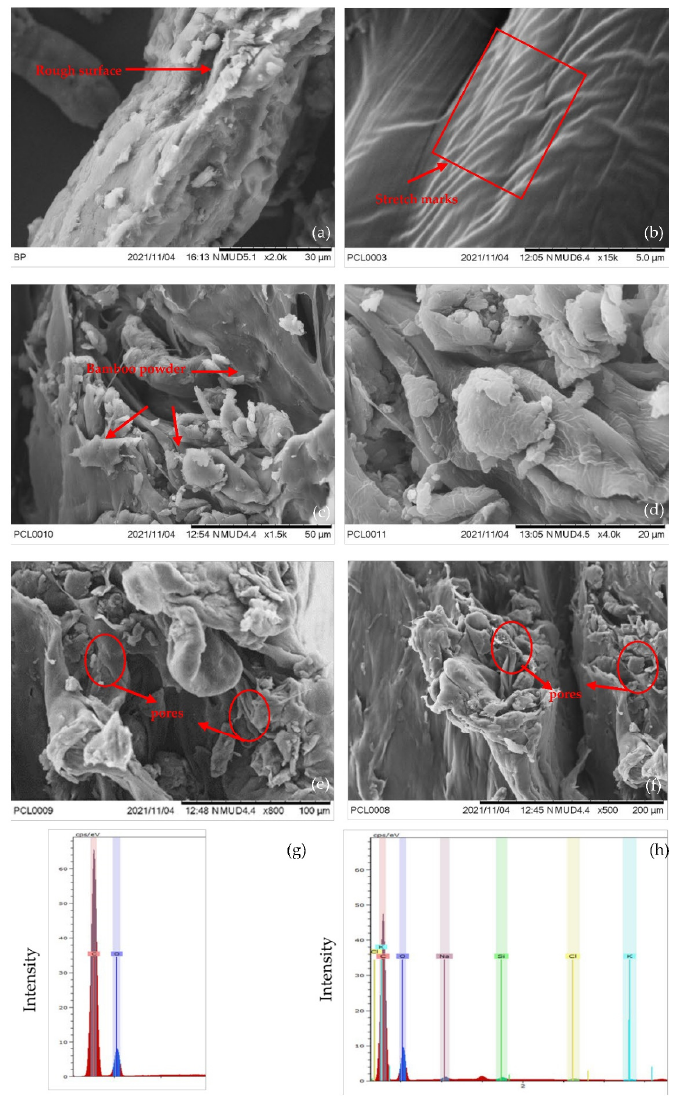
Figure 2. SEM micrographs of ( a ) BP; ( b ) PCL; ( c ) PCL-BP30; ( d ) PCL-BP40; ( e ) pores of PCL-BP30; ( f ) pores of PCL-BP40; EDX spectra of ( g ) PCL and ( h ) PCL-B40.